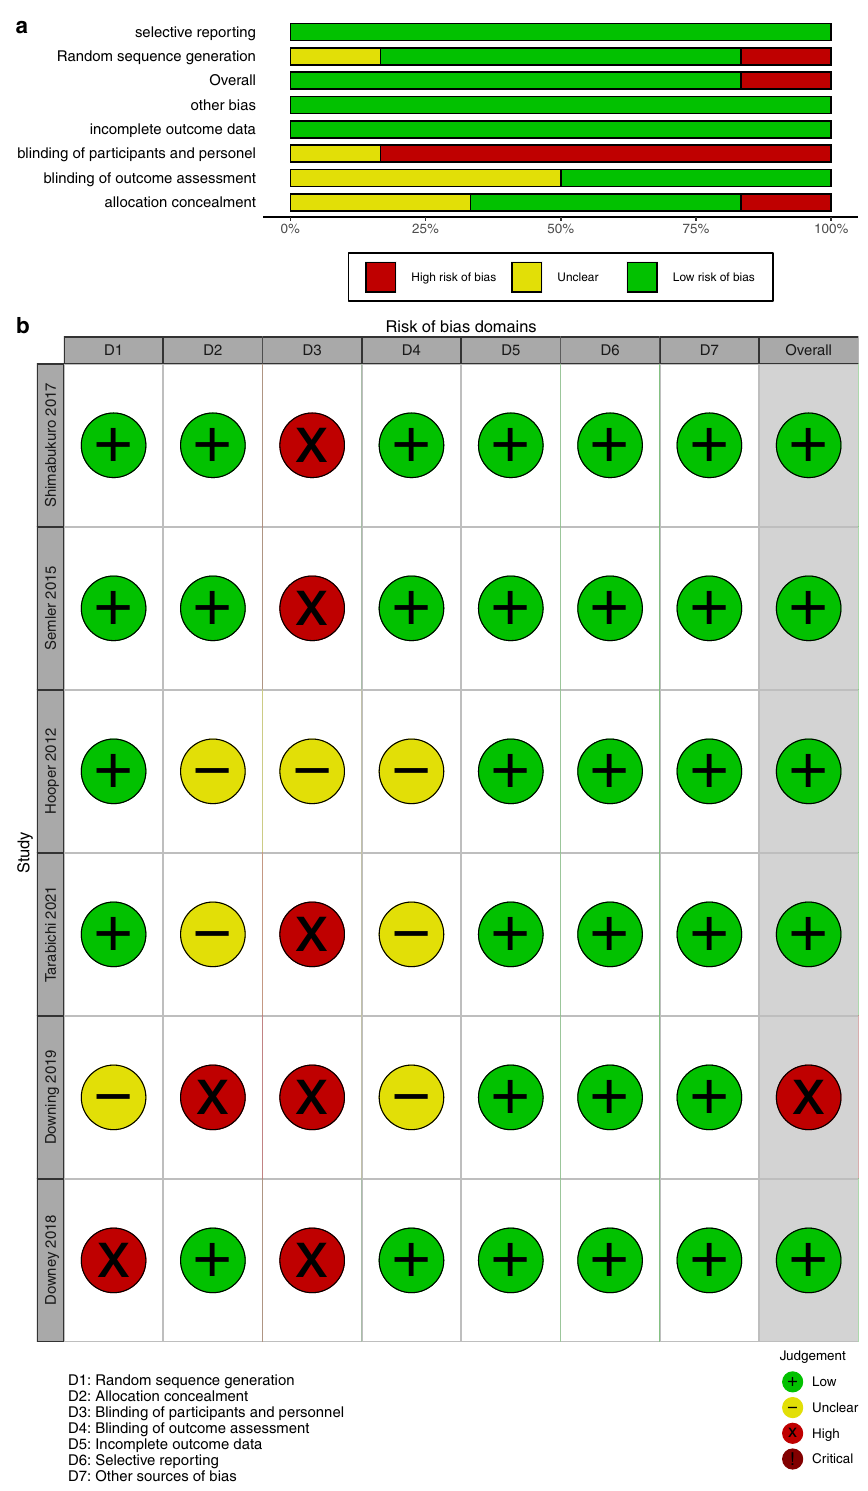
Fig. 2 Risk of bias assessment for randomized controlled trials. a Summary statistics for the risk of bias assessment for RCT. b Risk of bias assessment for each RCT. RCT randomized controlled